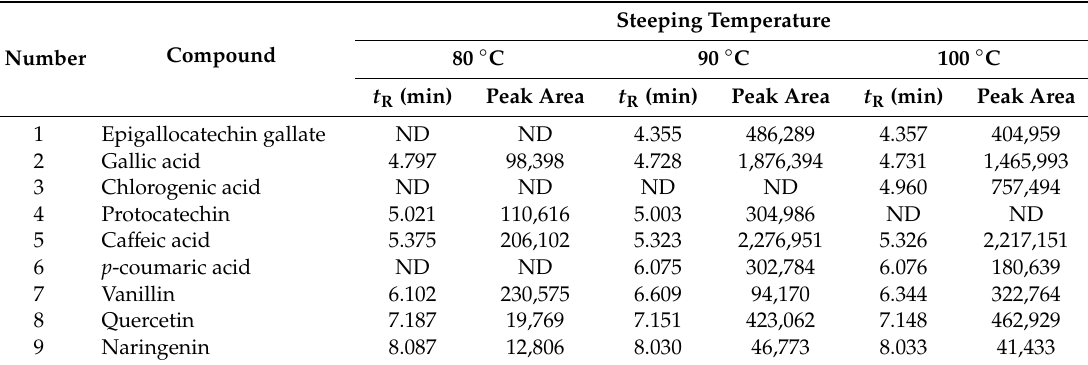
Table 4. Phenolic composition of infusions obtained from flowers and leaves of Cunila polyantha dried at 50 ◦ C for 6 h and prepared at di ff erent steeping temperatures (80, 90, and 100 ◦ C) identified by high-performance liquid chromatography (HPLC-PDA).